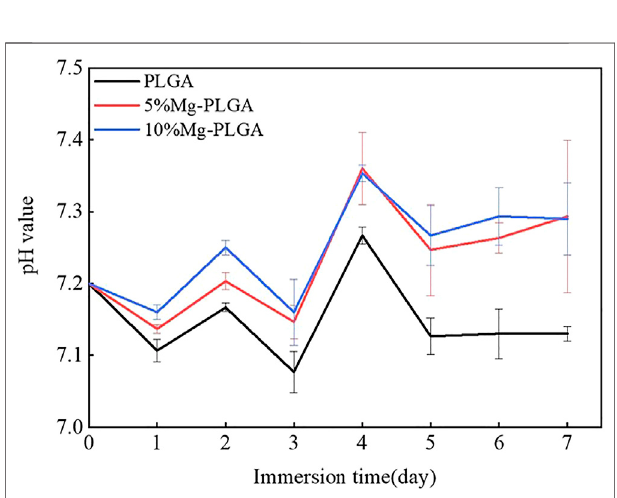
FIGURE 3 | Results of pH value monitoring. The peak value of three groupsappearedonthefourthday.Fromthe fi fthdayon,thepHvalueofthree groups leveled out gradually. With the increasing of the ratio of the magnesium, the pH value increased correspondingly between the P5% MggroupandP10%Mggroup.TheaveragevalueoftheP10%Mggroupwas closer to the normal physiological